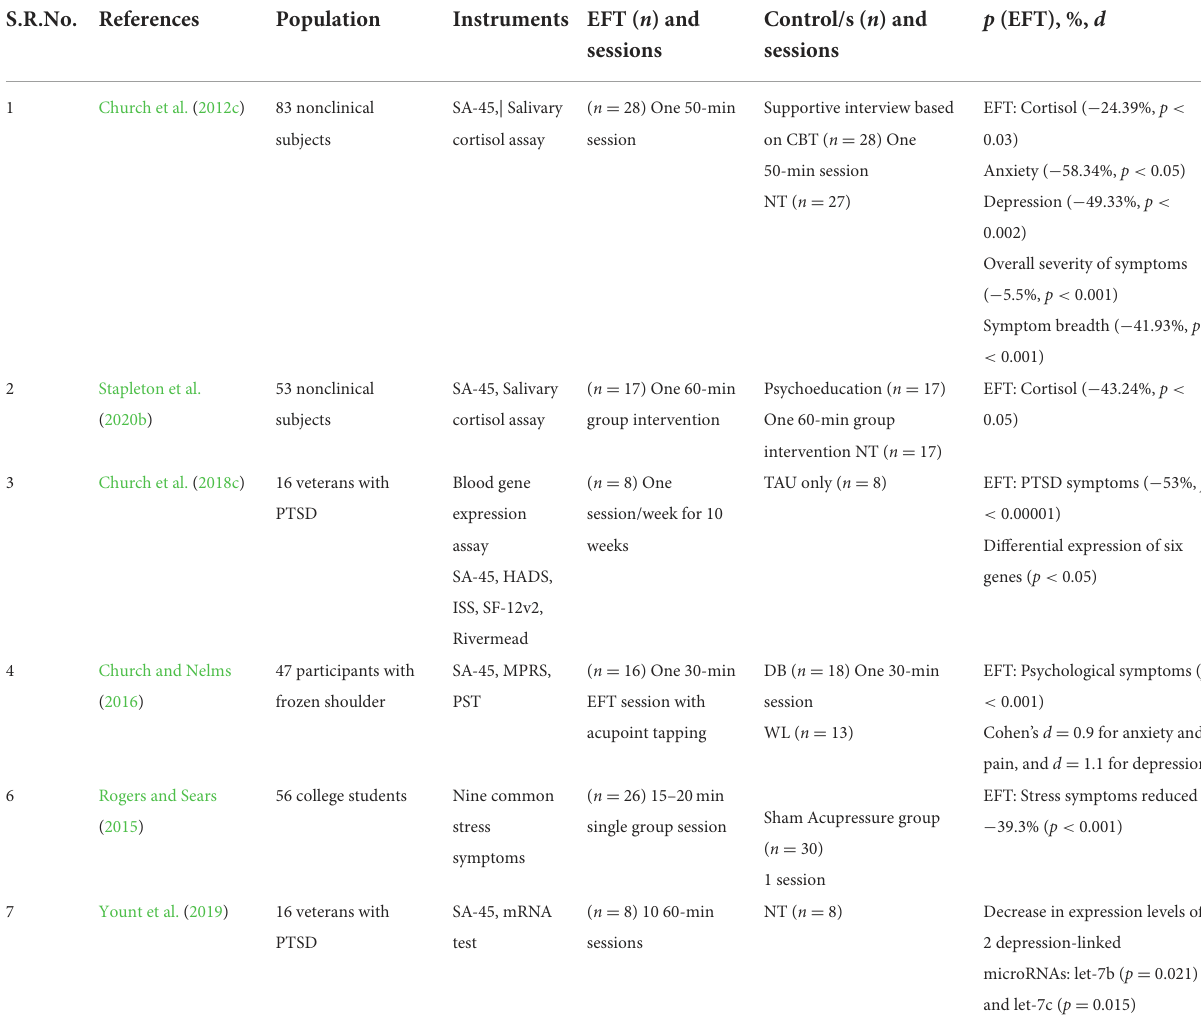
TABLE 16 RCTs illuminating EFT’s mechanisms of physiological